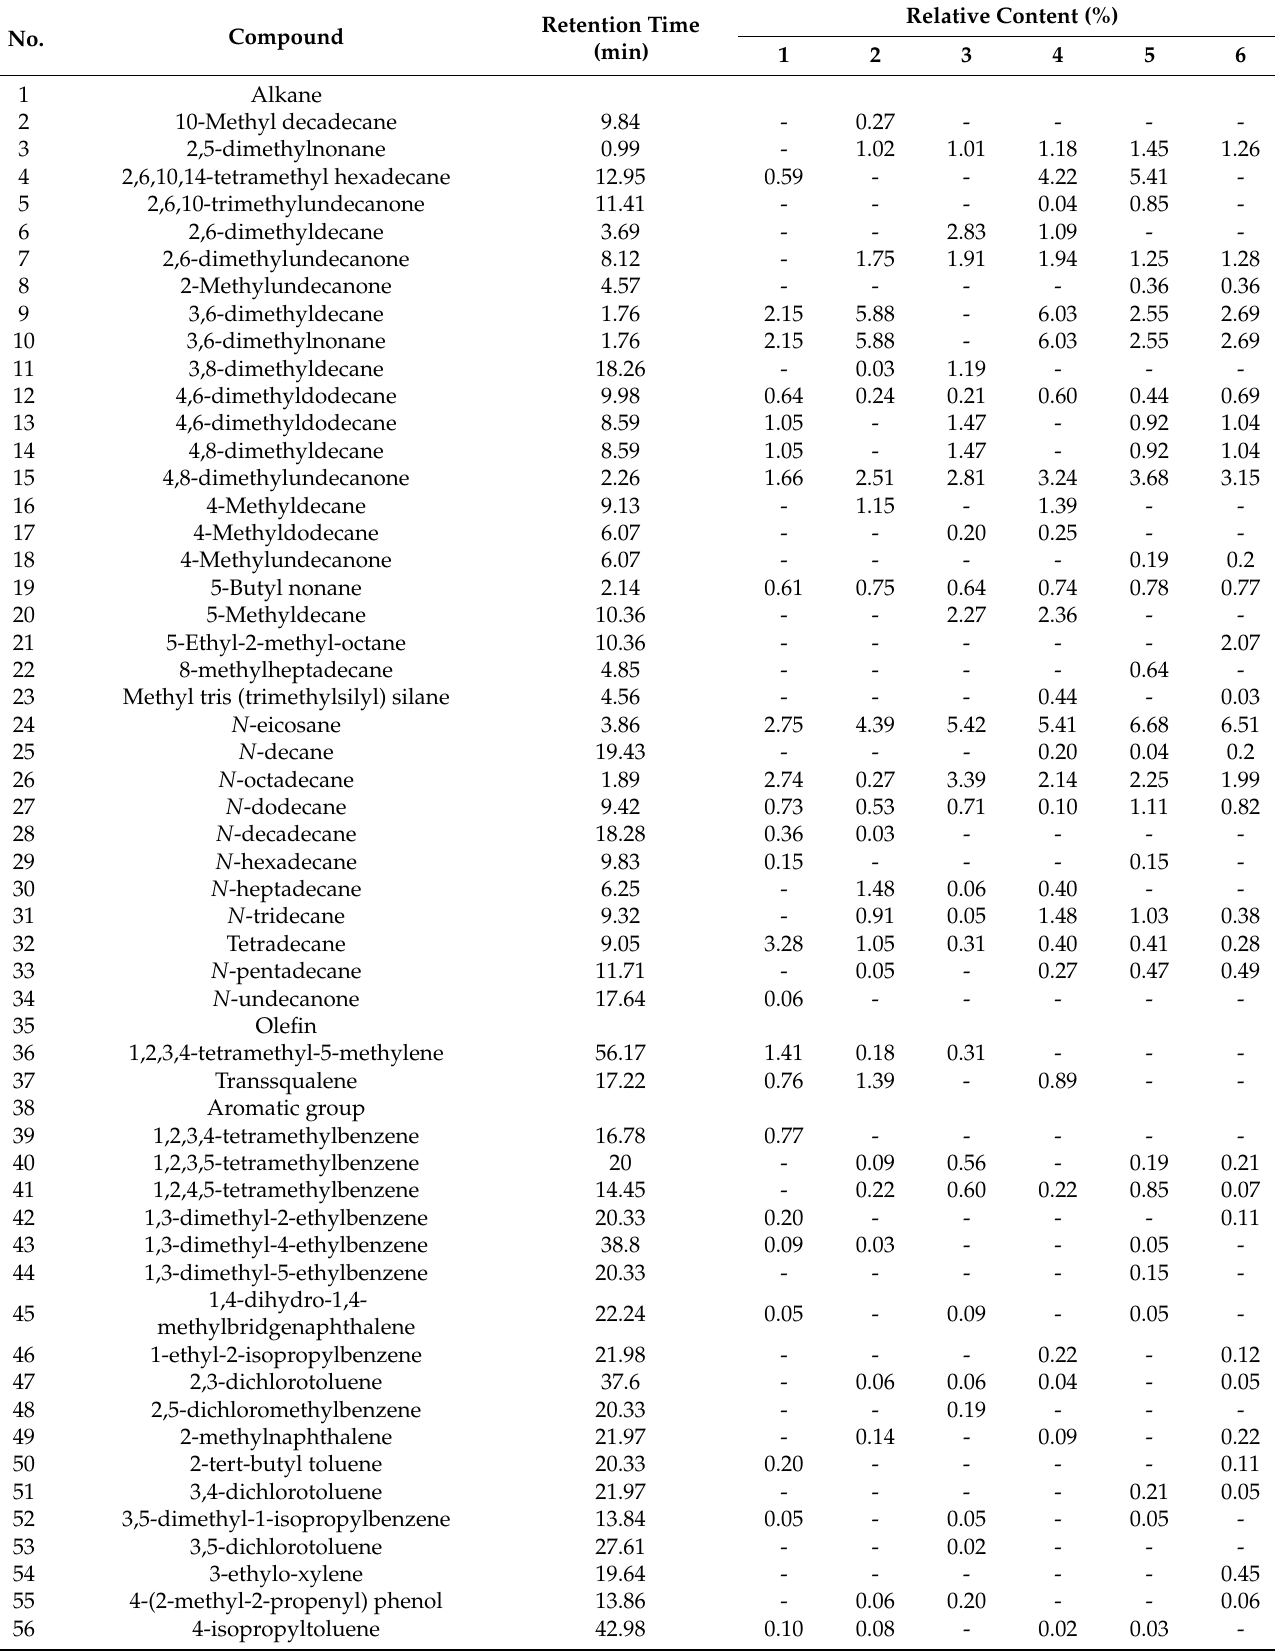
Table 2. GC-MS results of Bletilla striata